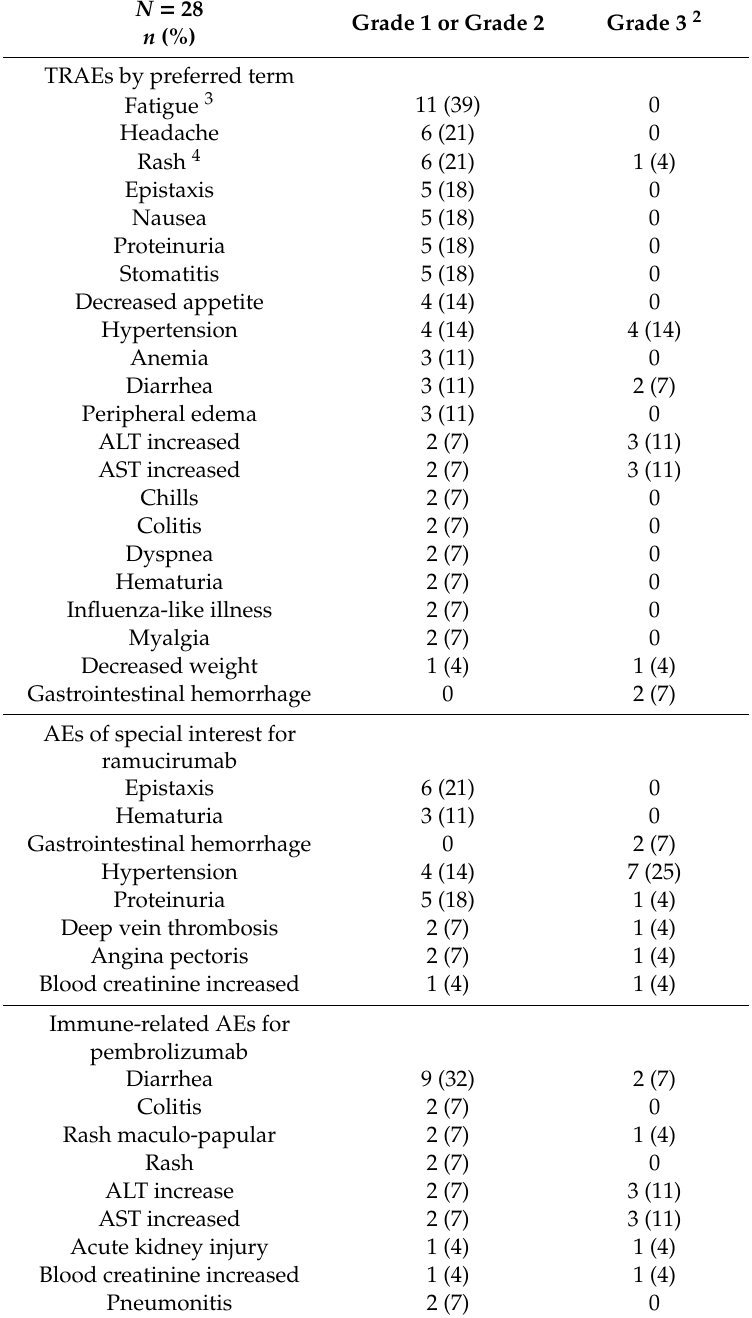
Table 2. Summary of treatment-related adverse events and treatment-emergent adverse events of special interest 1 , irrespective of relatedness occurring in ≥ 5% of the total patient